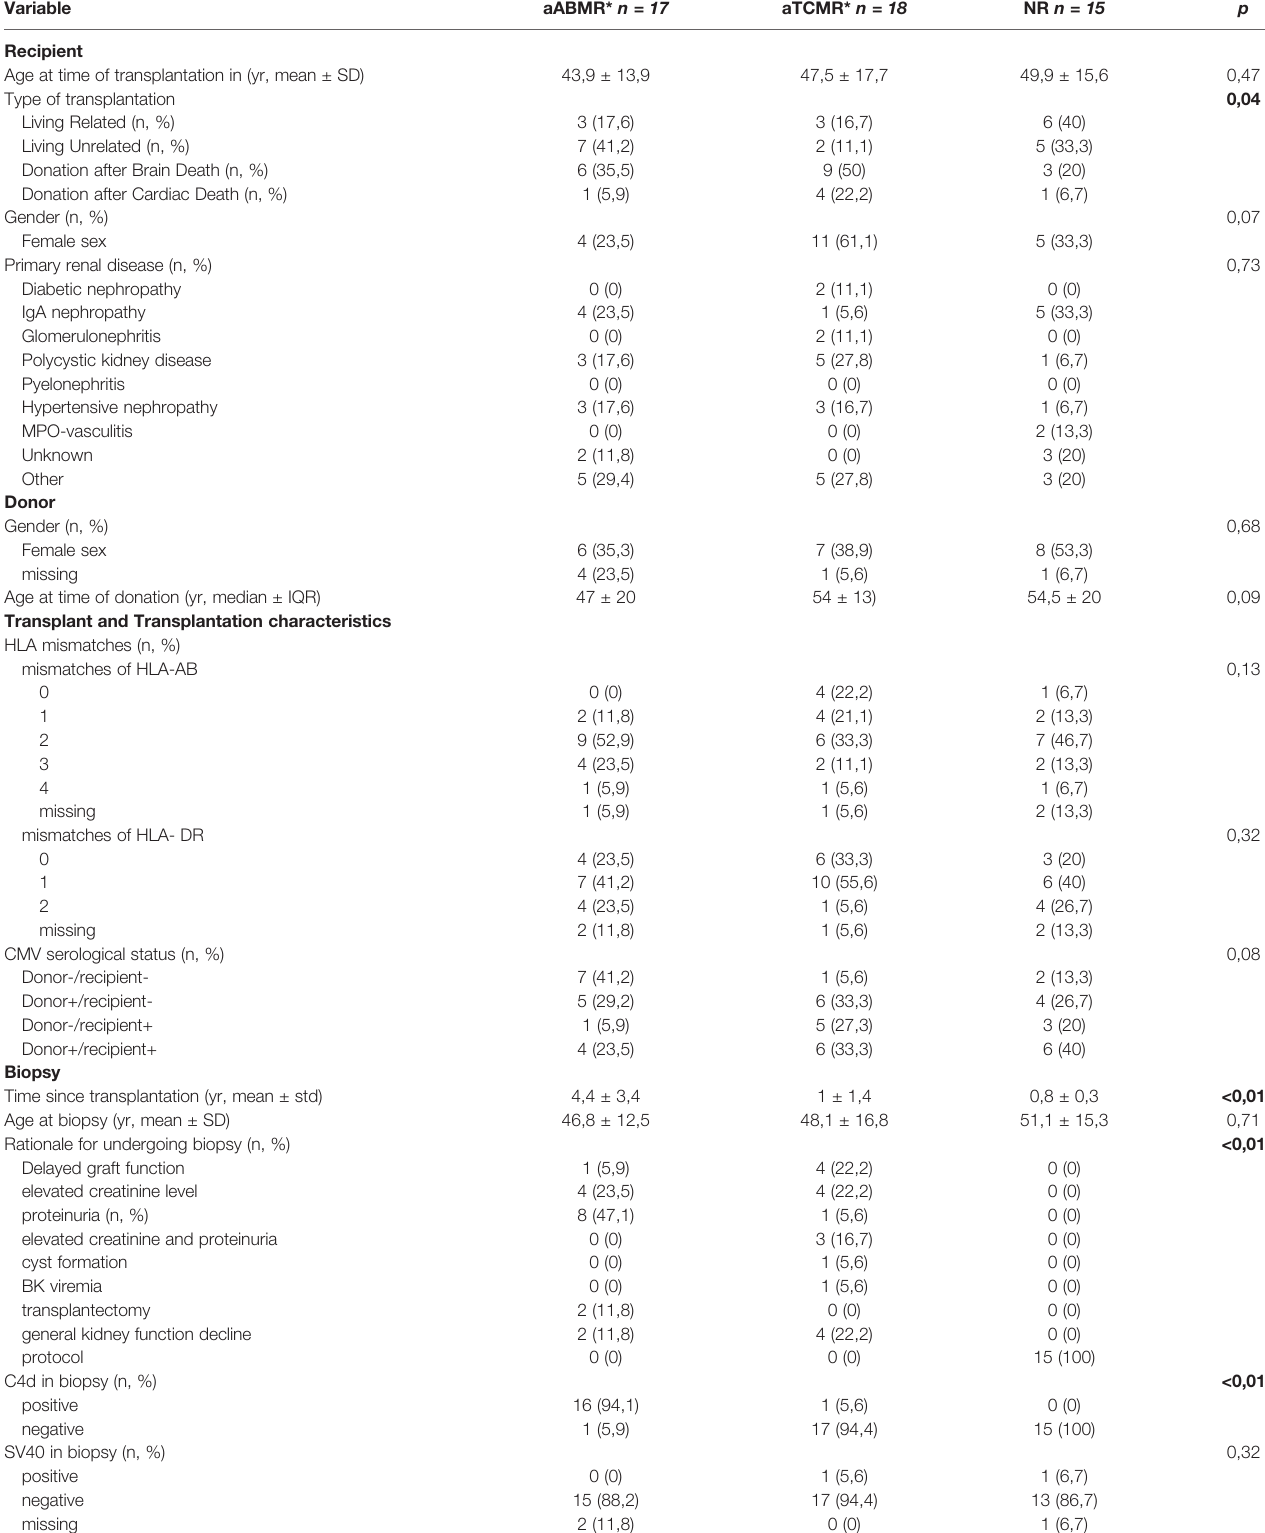
TABLE 4 | Baseline characteristics of aABMR, aTCMR, and NR